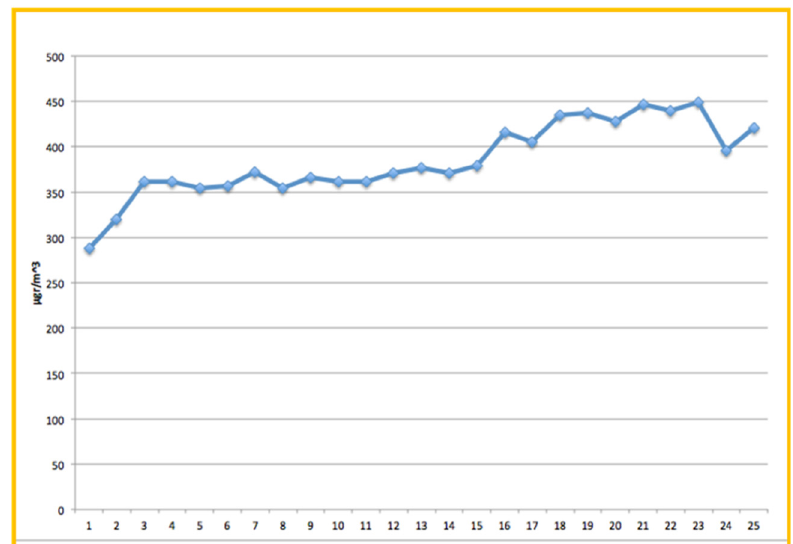
Figure 4. Background levels of TVOCs, during the operation of the dental Clinic without any laser activity, and no ventilation. The negative impact of no-ventilation during dental activity on the air quality, is obvious (safety limit is considered at 300 μ g/m 3 ).